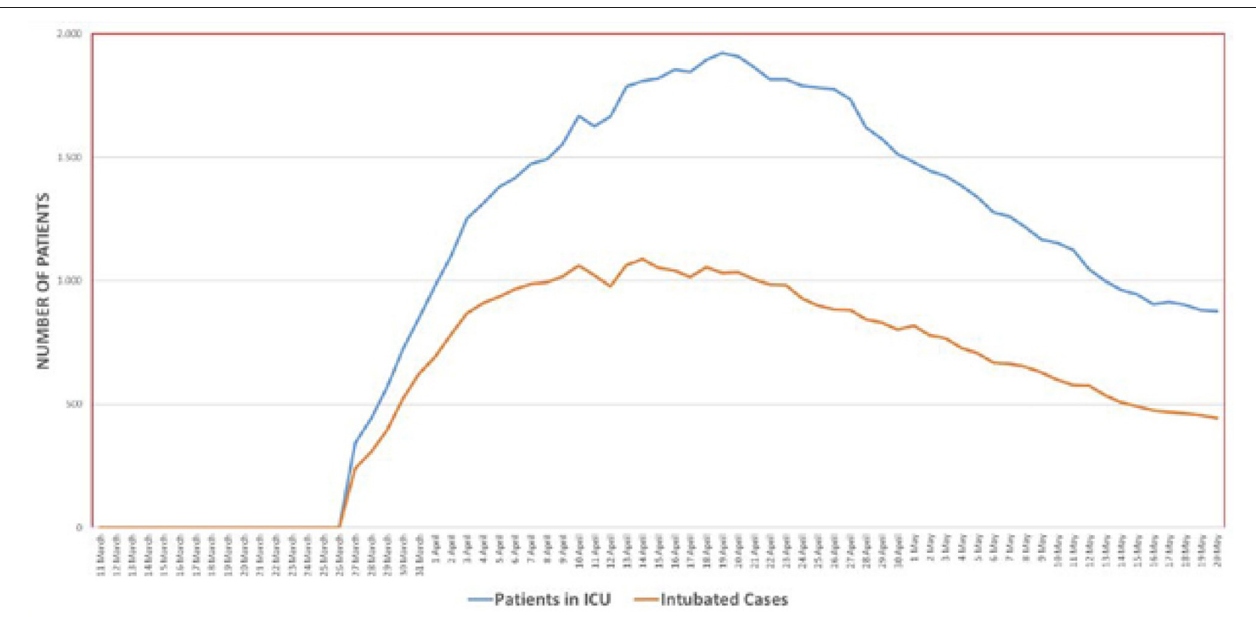
FIGURE 5 | The number of patients in intensive care and those who were intubated. Source: Daily reporting from the Directorate General for Health Information Systems, Ministry of Health, Turkey